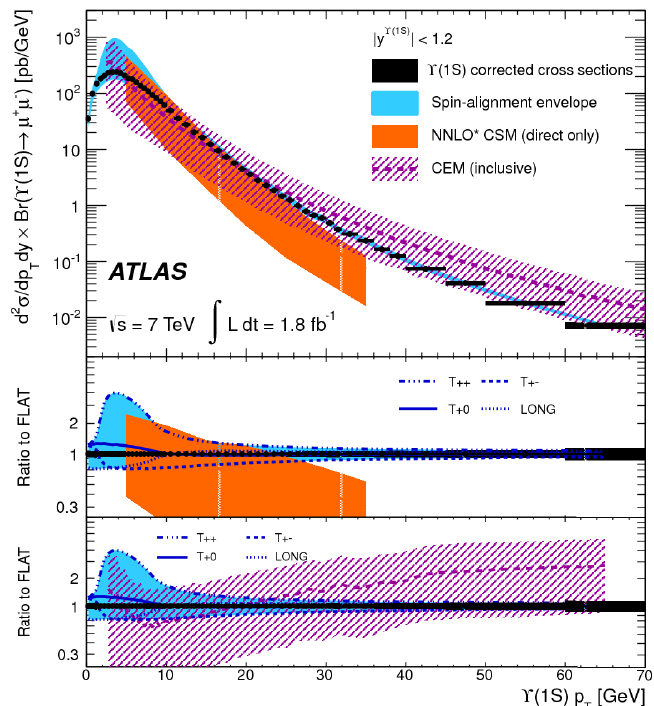
Figure 6: The Υ (1 S ) di ff erential cross sections multiplied by the di-muon branching fraction, d 2 / dp d y × Br( Υ → μ + μ − T